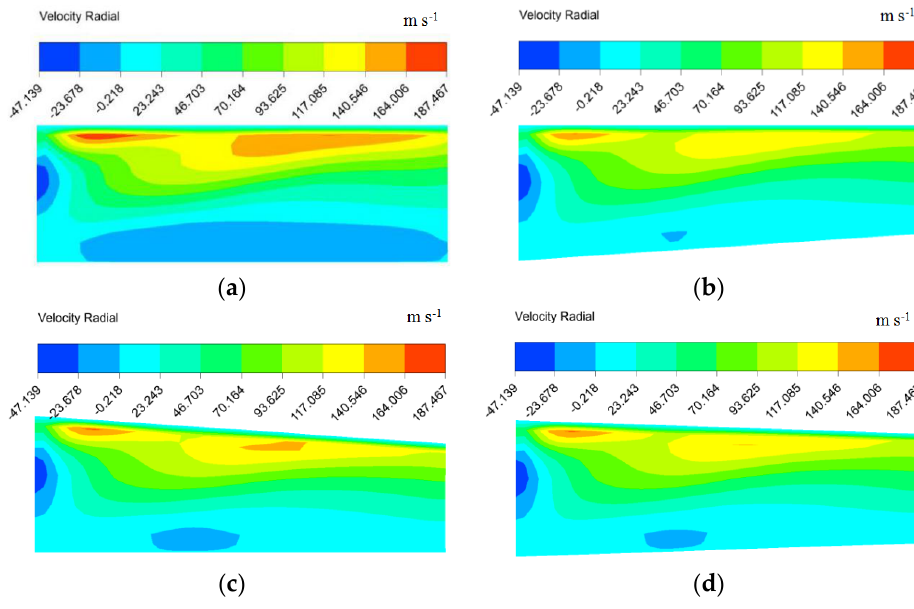
Figure 5. Radial velocity distribution on the meridional surface at 1.125 relative mass flow: ( a ) parallel; ( b ) convergence from shroud; ( c ) convergence from hub; ( d ) equal convergence from shroud and hub.